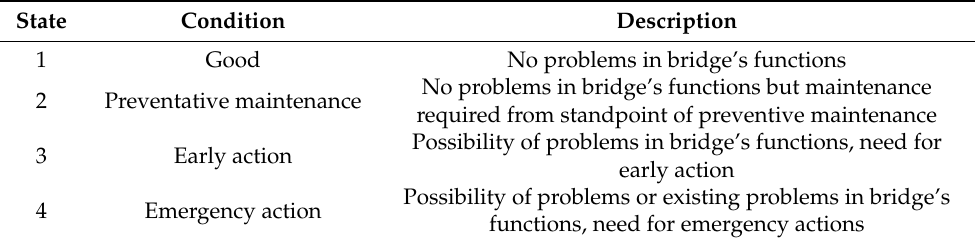
Table 3. Bridge soundness in